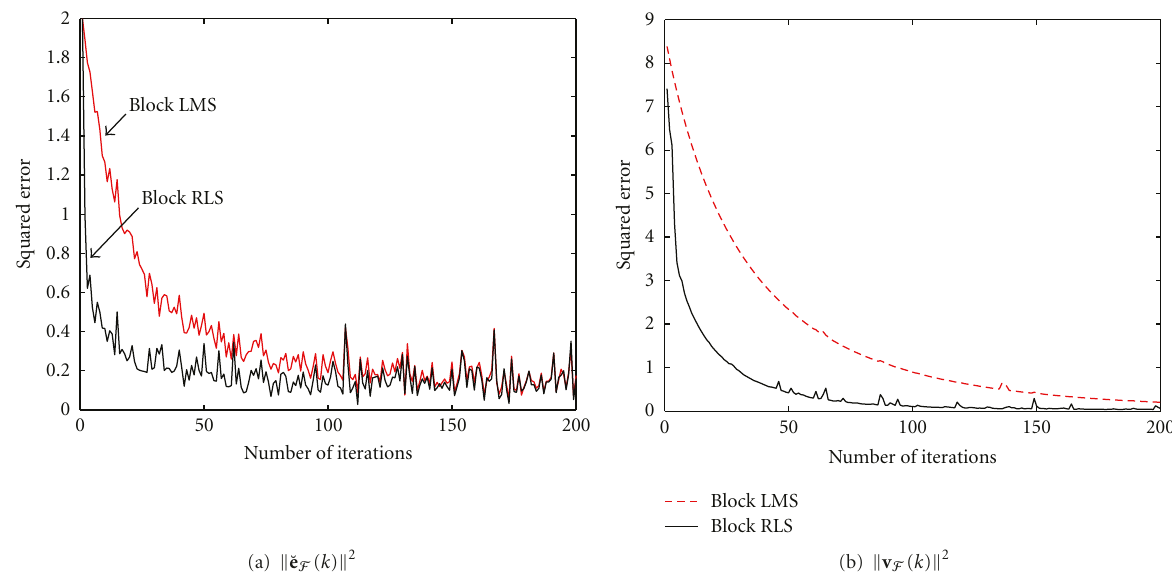
Figure 6: Transient behavior of squared error (cid:10) ˘ e F ( k ) (cid:10) 2 and (cid:10) v F ( k ) (cid:10) 2 of the block-wise LMS and RLS algorithms. f d T = 10 − 4 . Block RLS: λ = 0 . 8; block LMS: μ = 0 . 08.